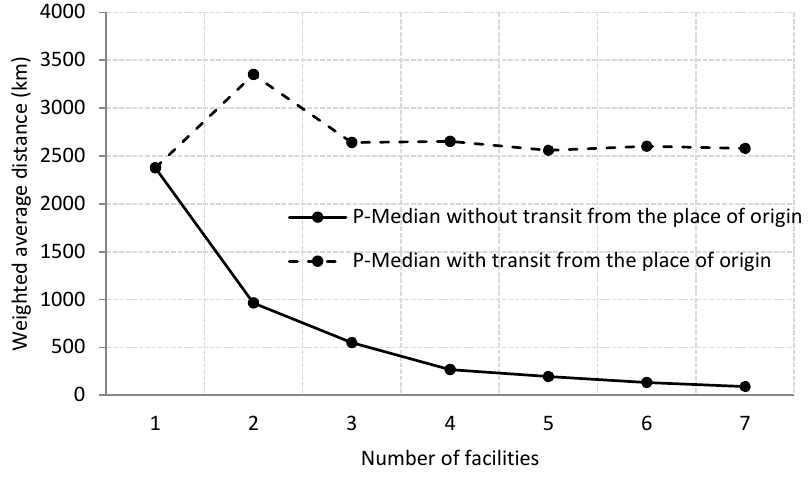
Figure 4. Median tradeoff curve. Source: own elaboration.